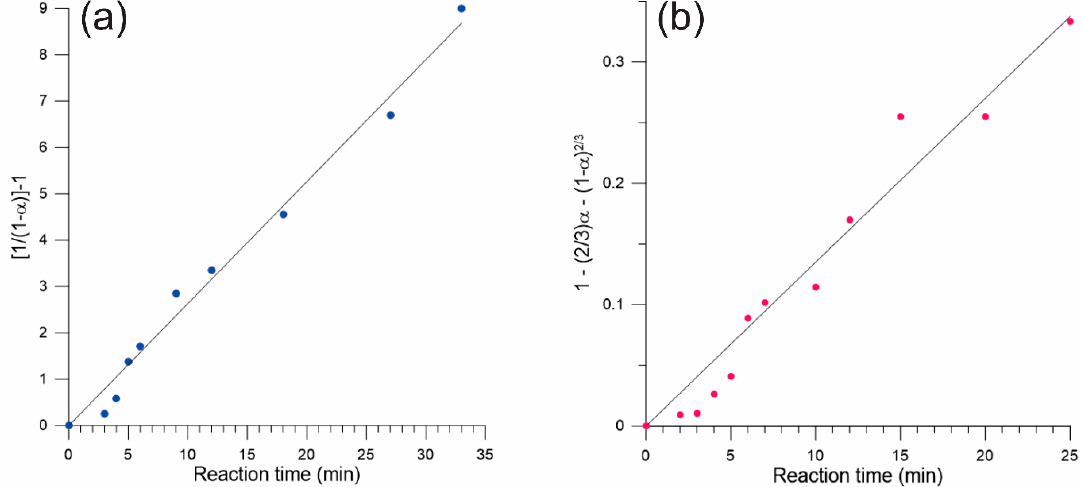
Figure 6. The isothermal integral reaction models for: ( a ) the neat mechanochemical synthesis of TTF-CA (blue circles), k = 0.263 min − 1 and R 2 = 0.994; and ( b ) the LAG synthesis with diethyl ether, η = 1 µ L / mg (magenta circles), k = 0.0135 min − 1 and R 2 = 0.979.